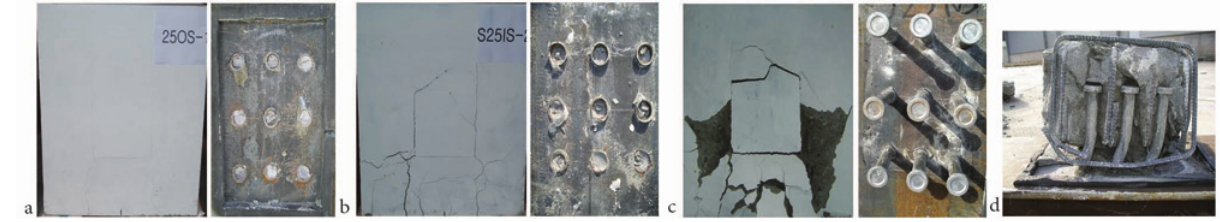
Fig. 5. Failure patterns of group stud shear connection in precast deck: a – G25OS-1 (Mode 1); b – GS25IS-2 (Mode 2); c – G25NS (Mode 3); d – effect of internal reinforcement